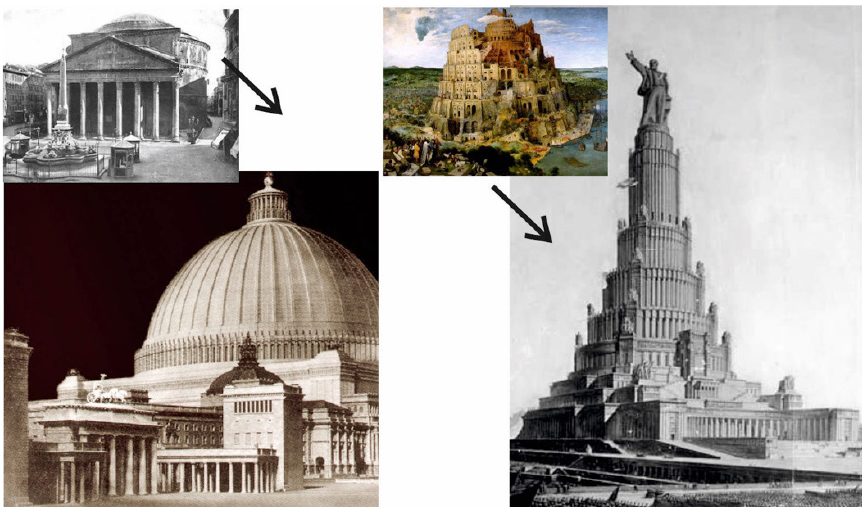
Figure 4. The method of historical association. Comparison of the Hall of Fame in Berlin and the Palace of Soviets in Moscow with ancient and mythological prototypes (source: author